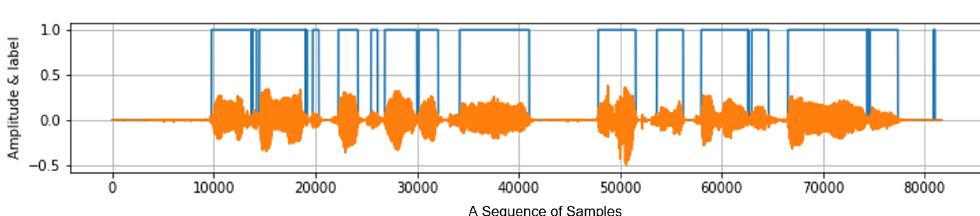
Figure 13. The accuracy variation of fuzzy clustering as the threshold is varied.